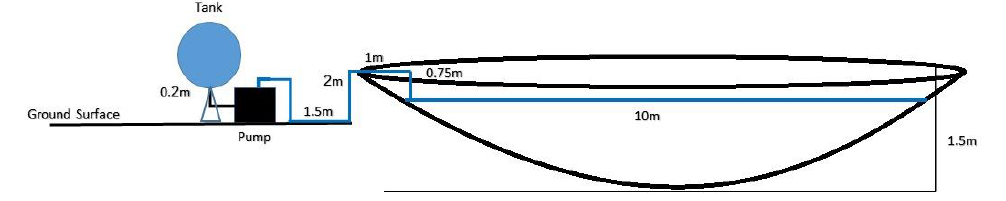
Figure 2. The typical head of the water pump.